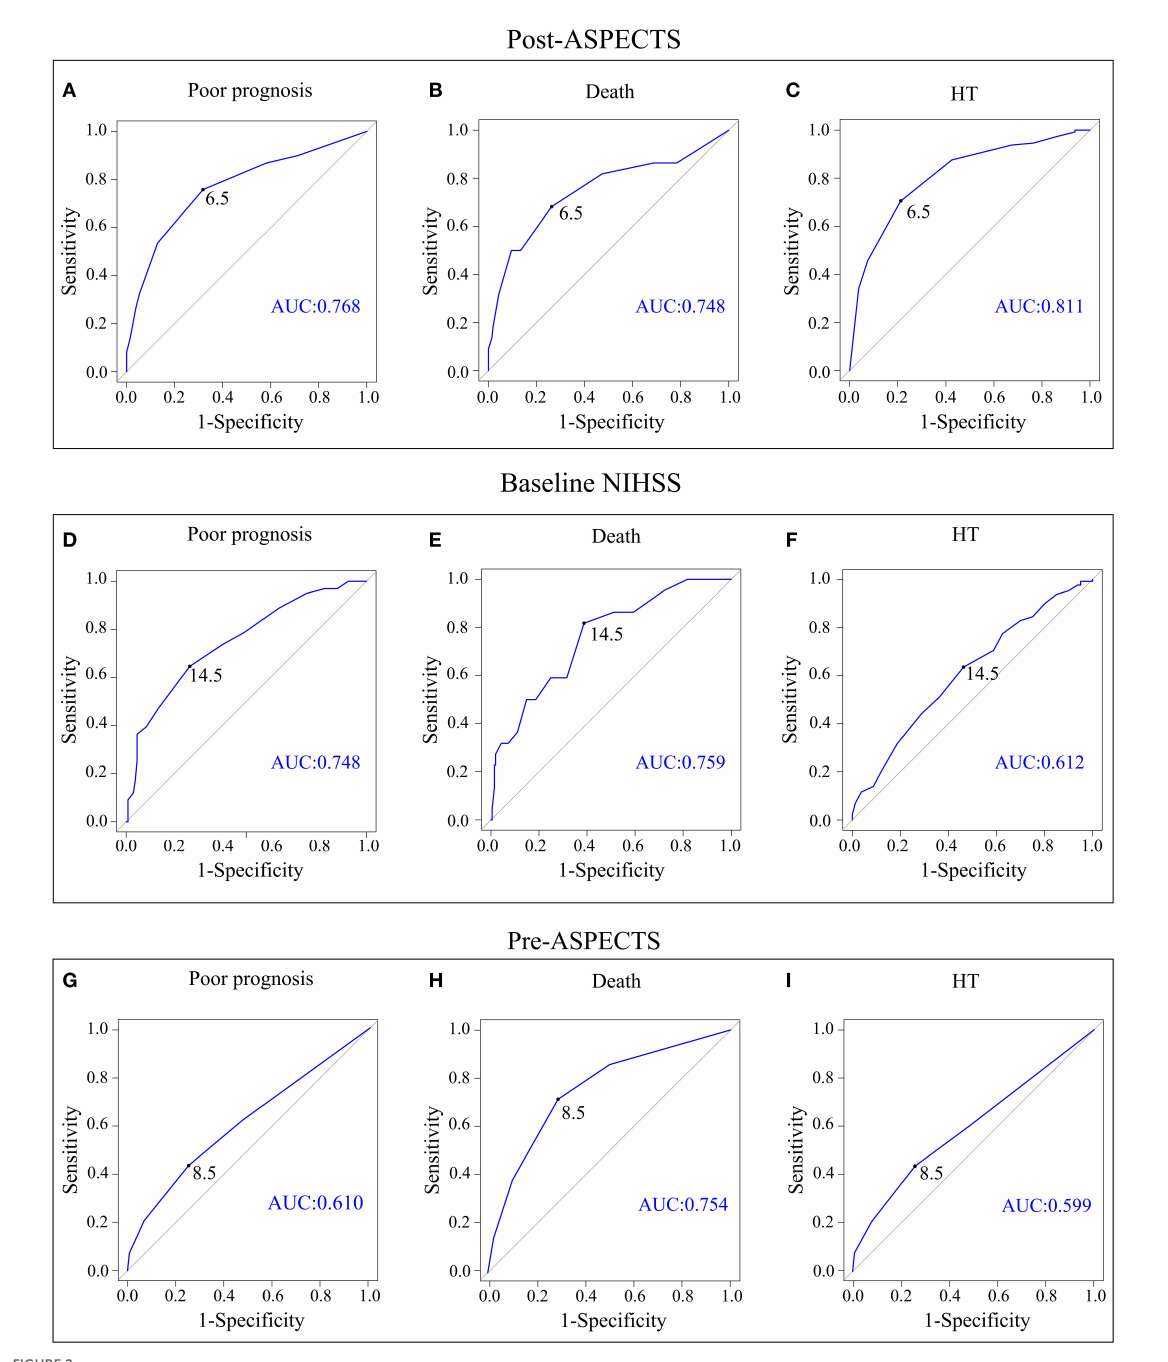
FIGURE2 ROC curve analysis plots of the Post-ASPECTS with 90-day poor prognosis (A) , 90-day death (B) , and HT (C) . The baseline NIHSS score with 90-day poor prognosis (D) , 90-day death (E) , and HT (F) . The Pre-ASPECTS with 90-day poor prognosis (G) , 90-day death (H) , and HT (I) . ROC, receiver operating characteristic; Pre-ASPECTS, pre-thrombectomy ASPECTS; Post-ASPECTS, post-thrombectomy ASPECTS; HT, hemorrhagic transformation.